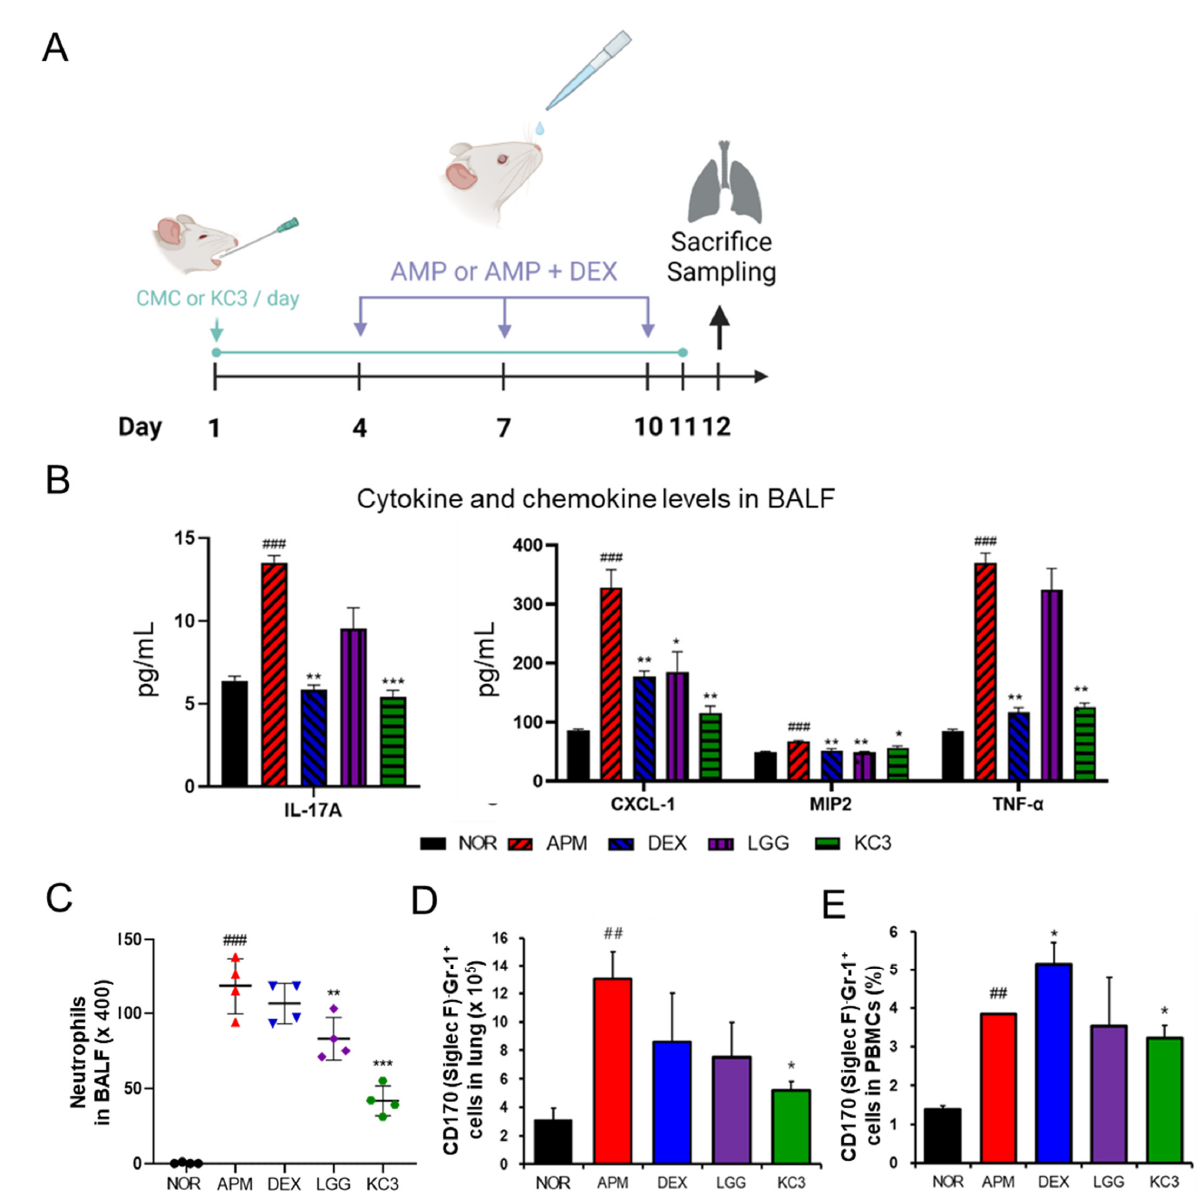
Figure 6. Anti-inflammatory effect of KC3 on ambient particulate matter (PM)-induced lung inflam- mation model. ( A ) Schematic of the experimental design. The PM was administered intranasally on days 4, 7, and 10. Treatment was conducted daily for 11 days by oral gavage. All mice were sacrificed on day 12 to harvest the BALF, lung tissues, and blood. The concentration of pro-inflammatory cytokine production ( B ) and the absolute number of neutrophils ( C ) were measured in the BALF. ( D ) The number of CD170 (Siglec F) - Gr-1 + neutrophils were measured by flow cytometry in the lung tissues. ( E ) The proportion of lymphocyte and neutrophil in PBMC was measured by flow cytometry. APM and DEX represent ambient PM and dexamethasone, respectively. *, **, *** Significant difference compared with the ambient PM control group ( p < 0.05, p < 0.01, p < 0.001). ## , ### Significant difference compared with the normal group ( p < 0.01, p < 0.001). Data are represented as mean ± SD ( n = 5 per